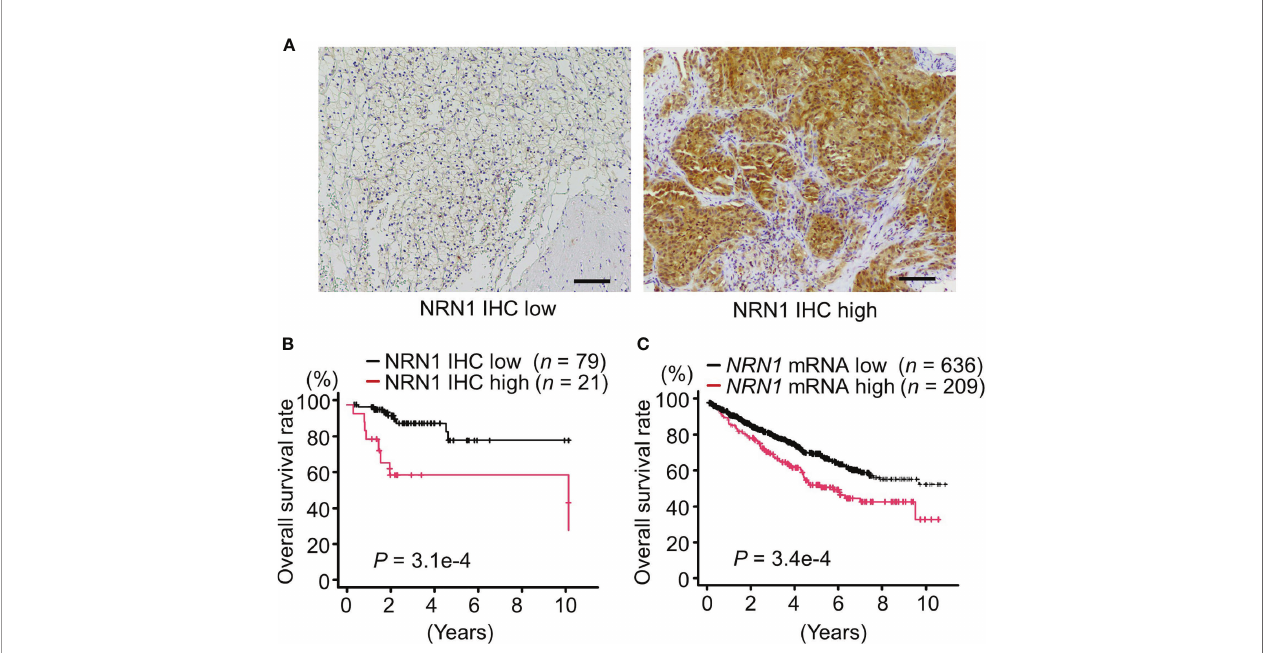
FIGURE 1 | NRN1 is a poor prognostic factor for patients with RCC. (A) Representative immunohistochemistry (IHC) staining of low (left panel) and high (right panel) expression of NRN1 in RCC tissue sections. Scale bars, 100 µm. (B) Overall survival of 100 patients with clear cell RCC (ccRCC) of low or high NRN1 immunoreactivity was analyzed by Kaplan-Meier method. Statistical signi fi cance was evaluated by log-rank test. (C) Overall survival of RCC patients with low or high NRN1 mRNA levels were analyzed by Kaplan-Meier method. NRN1 expression data in TCGA RCC dataset were retrieved from The Human Protein Atlas ( n = 845). High and low NRN1 expressions were determined at an expression cut off level as 6.6 fragments per kilobase of exon per million mapped fragments (FPKM) (expression level range: 0.1- 204.2, expression median level: 2.9 FPKM, P = 3.4e-4). Statistical signi fi cance was evaluated by log-rank